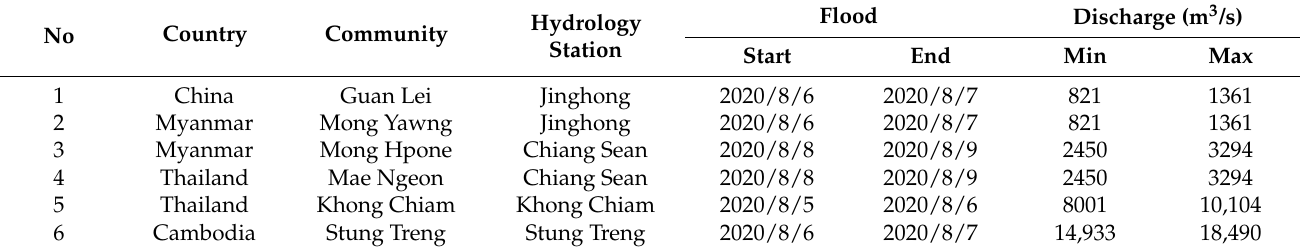
Table 2. Working